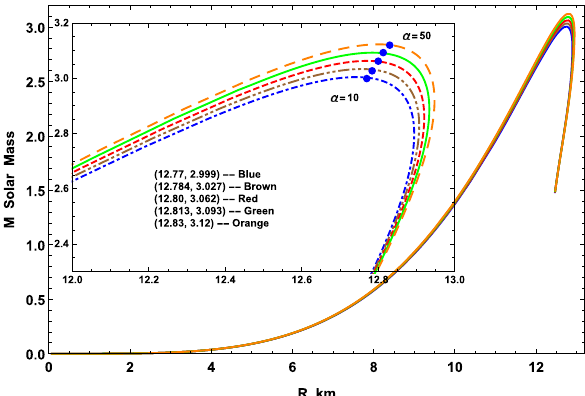
Fig. 13 The M – R graphs are plotted for a = 2 . 13 × 10 − 4 and b = 4 × 10 −